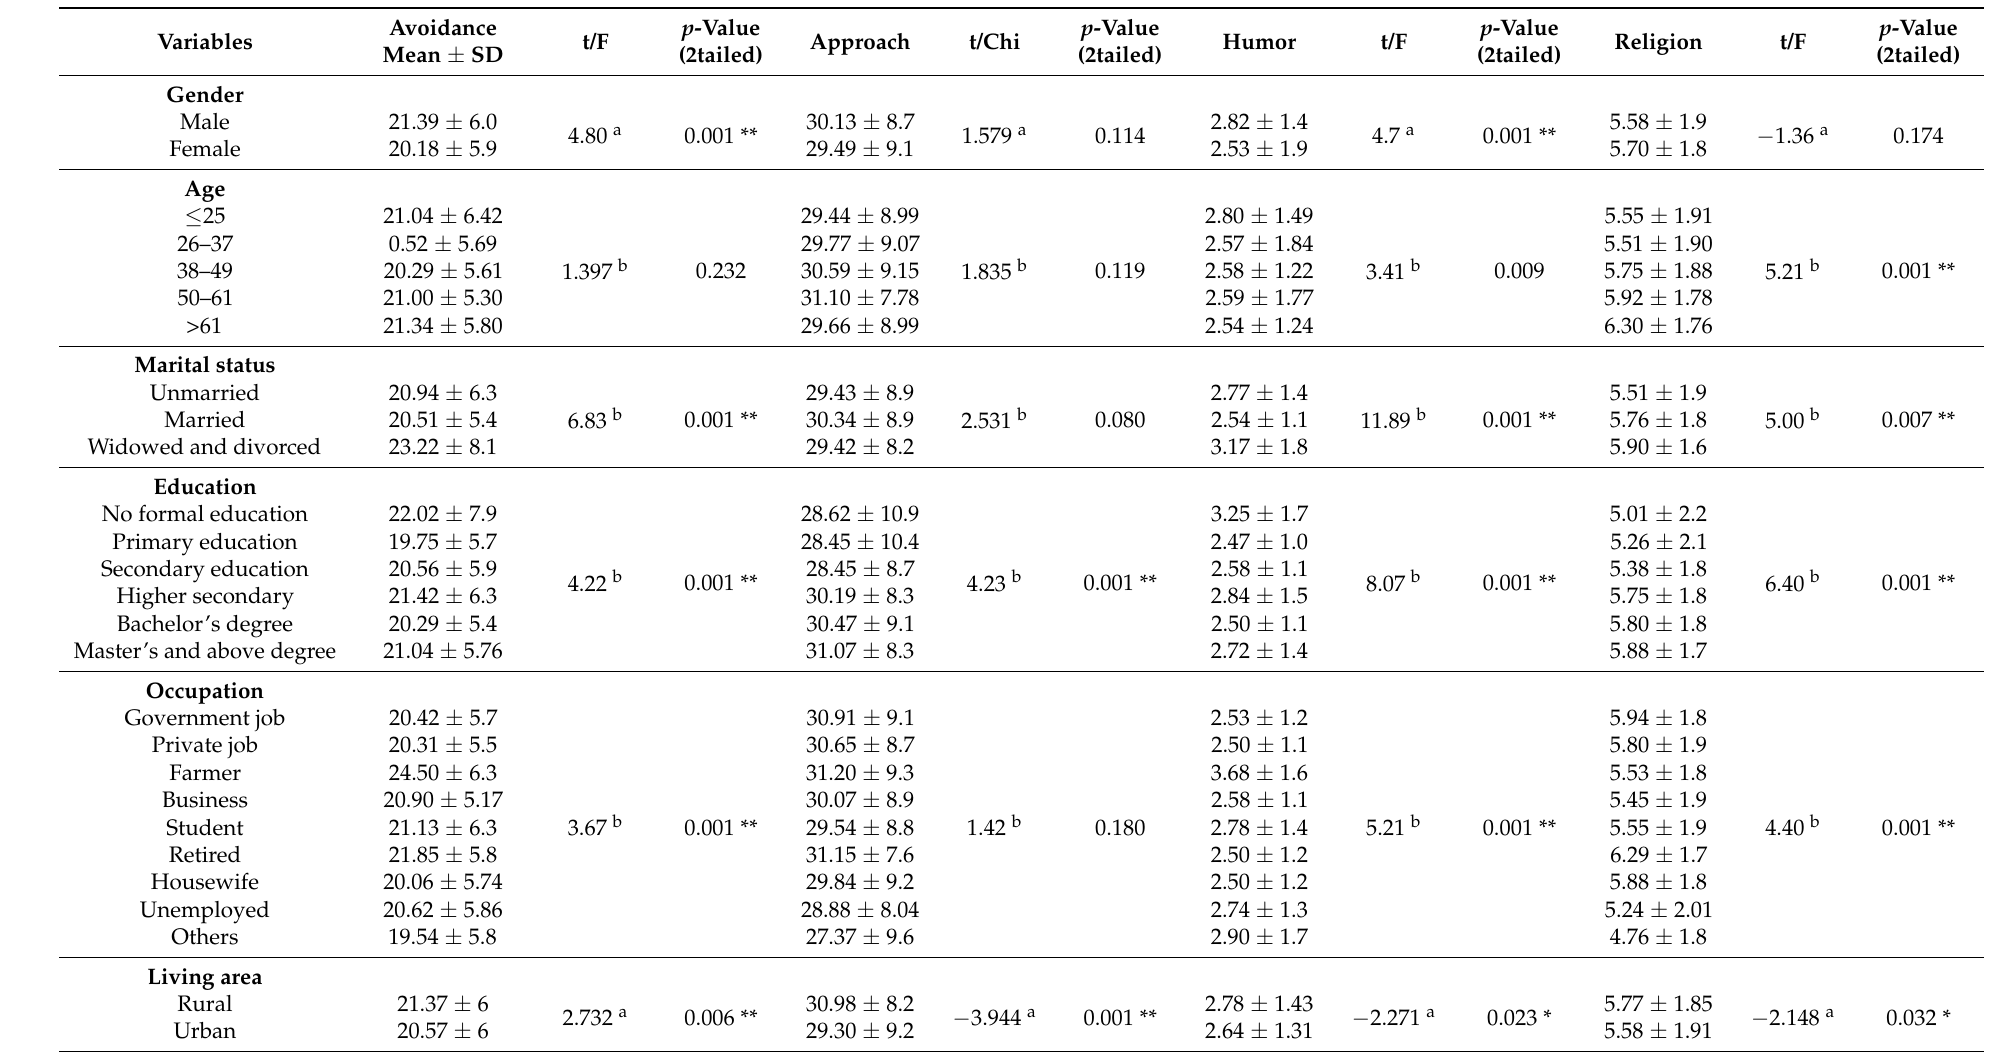
Table 3. Relationship of socio-demographic distribution and coping domains (n =